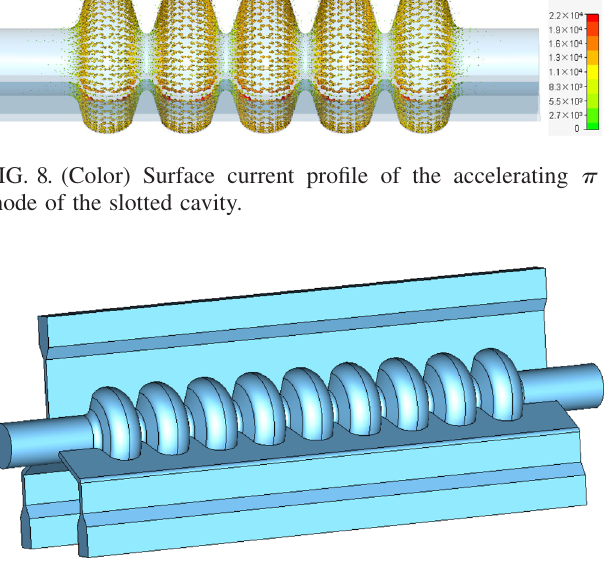
FIG. 10. (Color) Absorbing material (brown) position inside the waveguides.